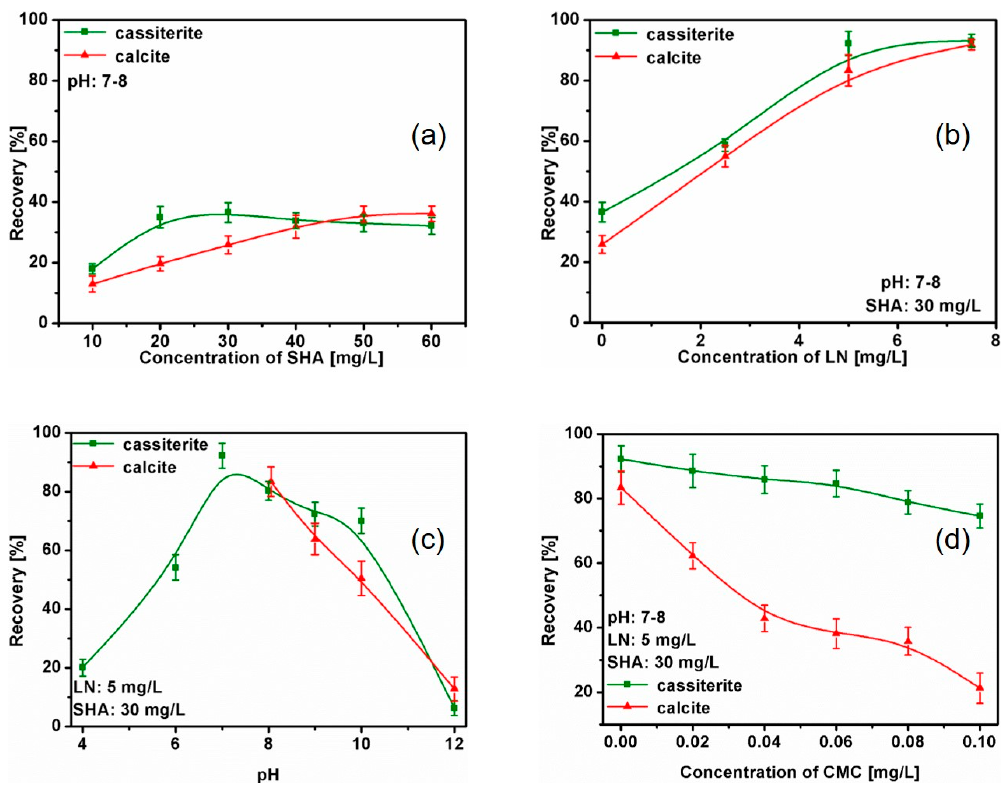
Figure 2. Recovery of cassiterite and calcite as a function of salicylhydroxamic acid (SHA) concentration ( a ), lead nitrate (LN) concentration ( b ), solution pH ( c ) and carboxymethyl cellulose (CMC) concentration ( d ).